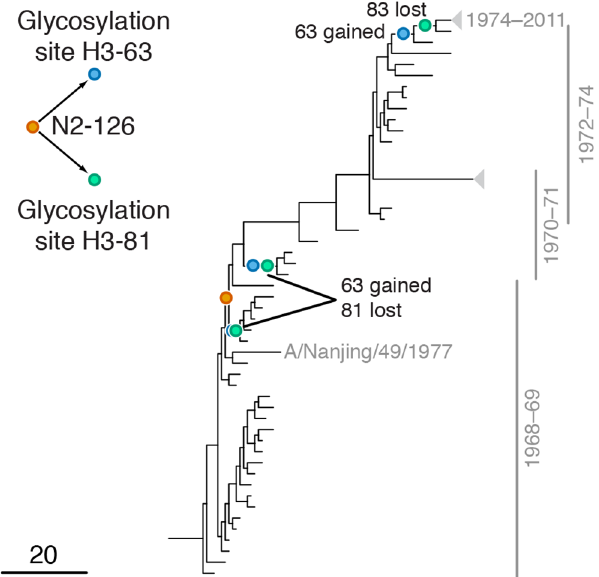
Fig 4. Example of putative inter-gene epistasis between sites N2-126 and H3-63 and H3-81. Mutations at sites N2-126 and glycosylation motifs starting at sites H3-63 and H3-81 are marked by orange, blue and green circles, respectively. All three mutations affecting the H3-63 glycosylation motif occurred at site H3-63 and created a new glycosylation site. Two mutations affecting the H3-81 glycosylation motif occurred at site H3-81 and one occurred at site H3-83, but all of them destroyed an existing glycosylation motif. Only mutations that form consecutive pairs are shown (see Materials and Methods); see S3 Data for all mutations. Vertical bars show years in which the isolates where sampled. The inset shows the inferred directionality of epistatic interactions with arrows pointing from the leading to the trailing